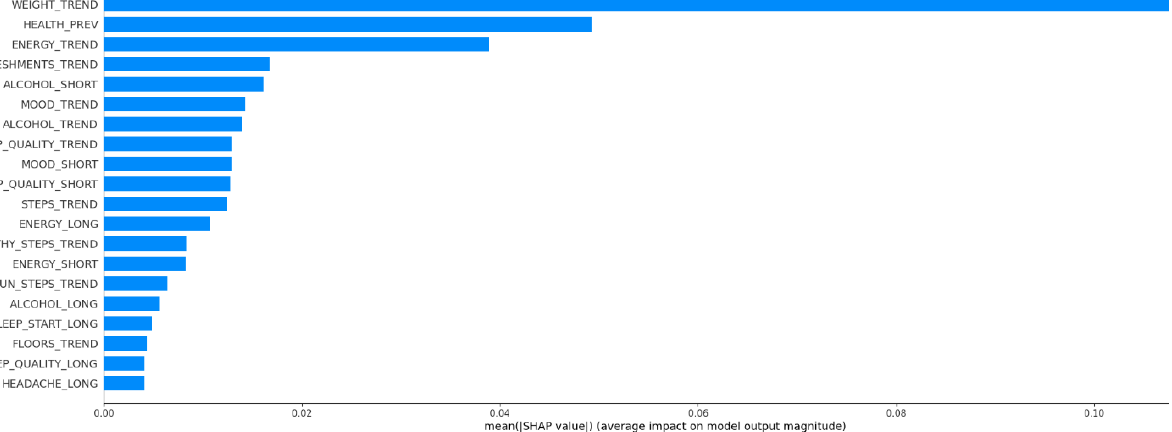
Figure 5. Average impact of feature vector elements on health change predictions utilizing previous health (20 most influential elements shown).